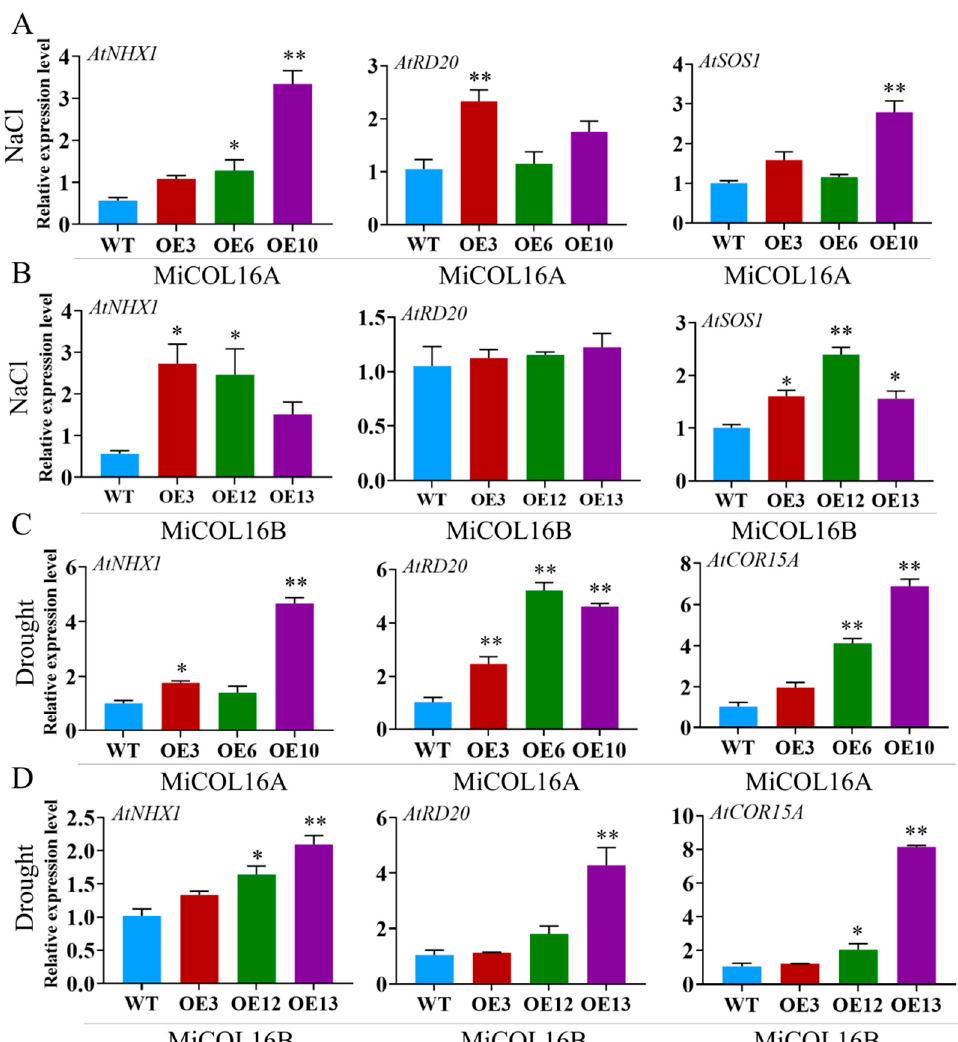
Figure 11. Expression patterns of stress-responsive genes in WT and MiCOL16A and MiCOL16B transgenic lines. ( A , B ) Salt stress conditions. Expression levels of the AtNHX1 , AtRD20 and AtSOS1 genes in MiCOL16A ( A ) and MiCOL16B ( B ) transgenic lines. ( C , D ) Drought stress conditions. Ex- pression levels of the AtNHX1 , AtRD20 and AtCOR15A genes in the MiCOL16A ( C ) and MiCOL16B ( D ) transgenic lines. Significant differences among the samples were assessed at the p < 0.05 (*) and p < 0.01 (**) levels by Student’s t tests.